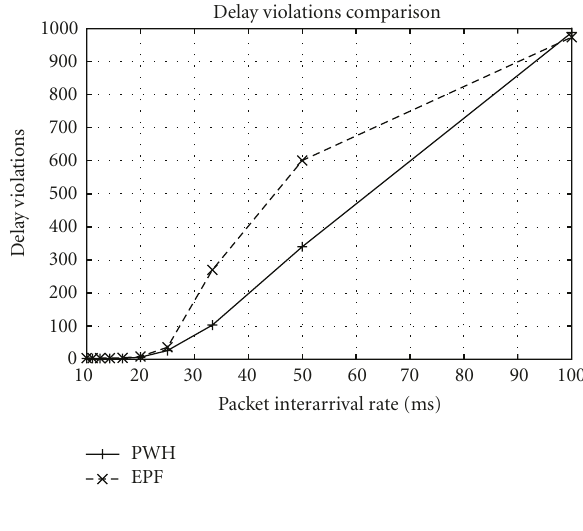
Figure 8: Delay violations versus load.